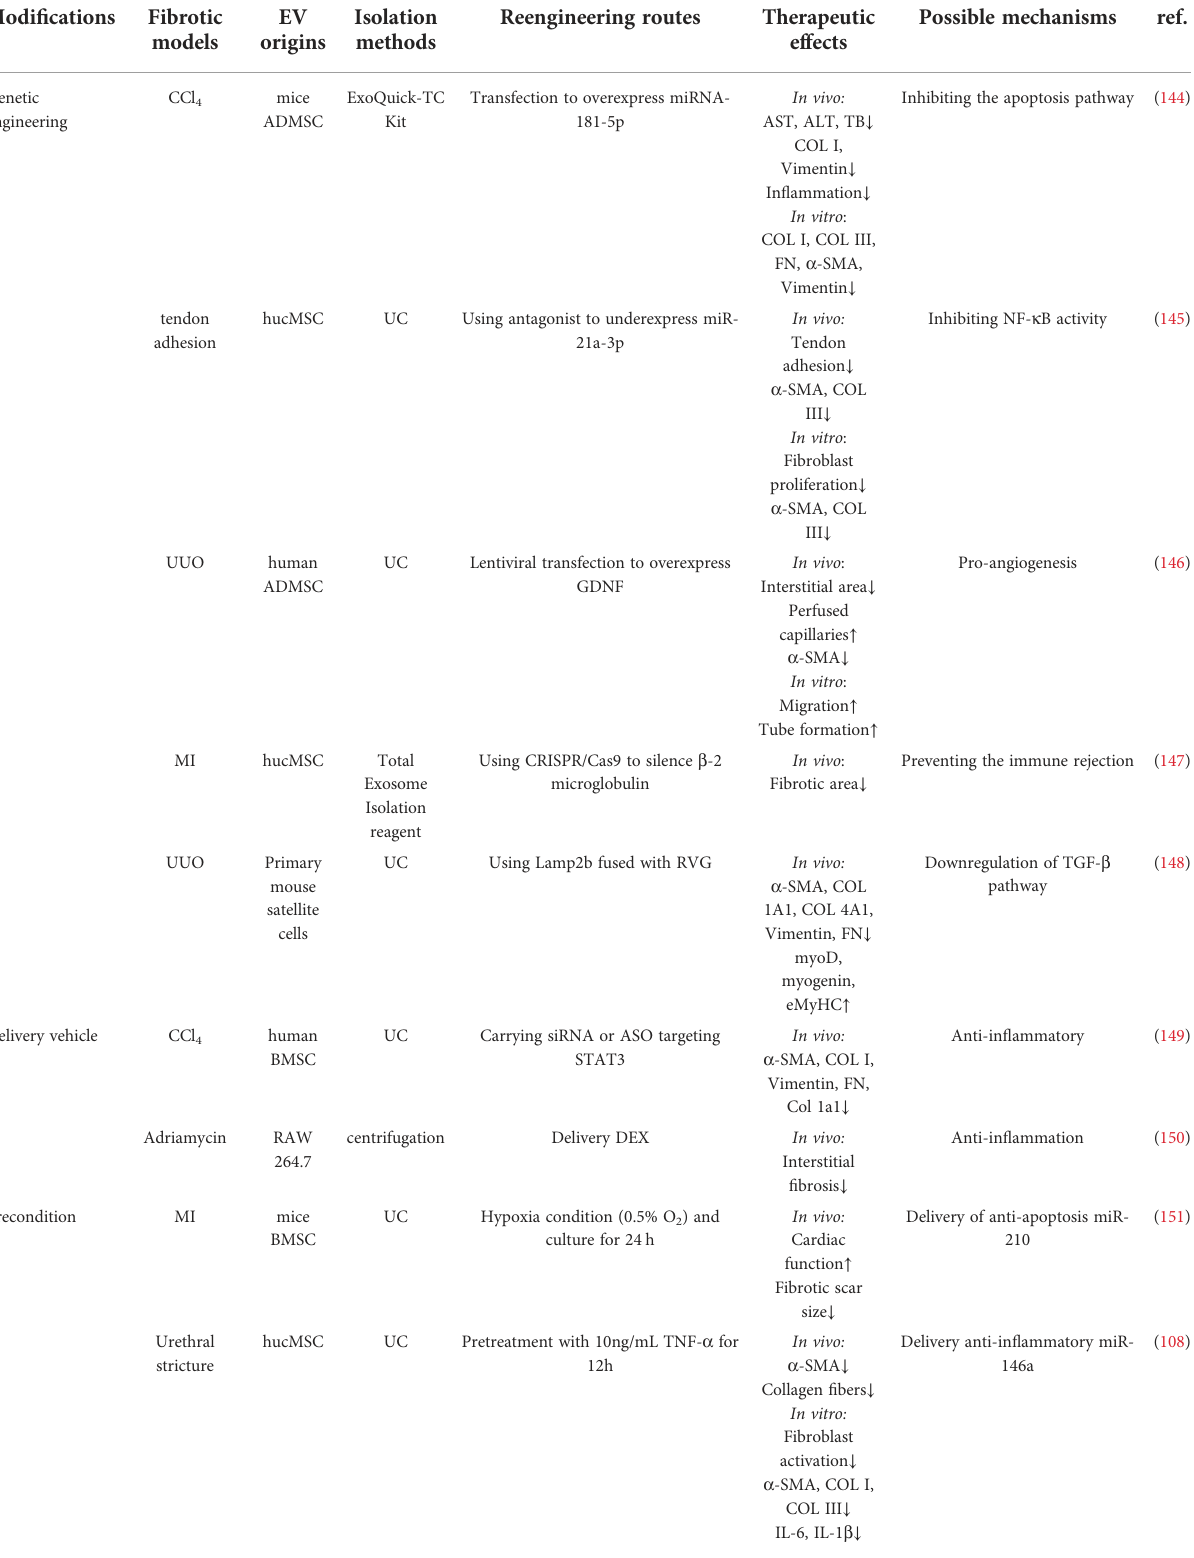
TABLE 2 Therapeutic effects of engineered